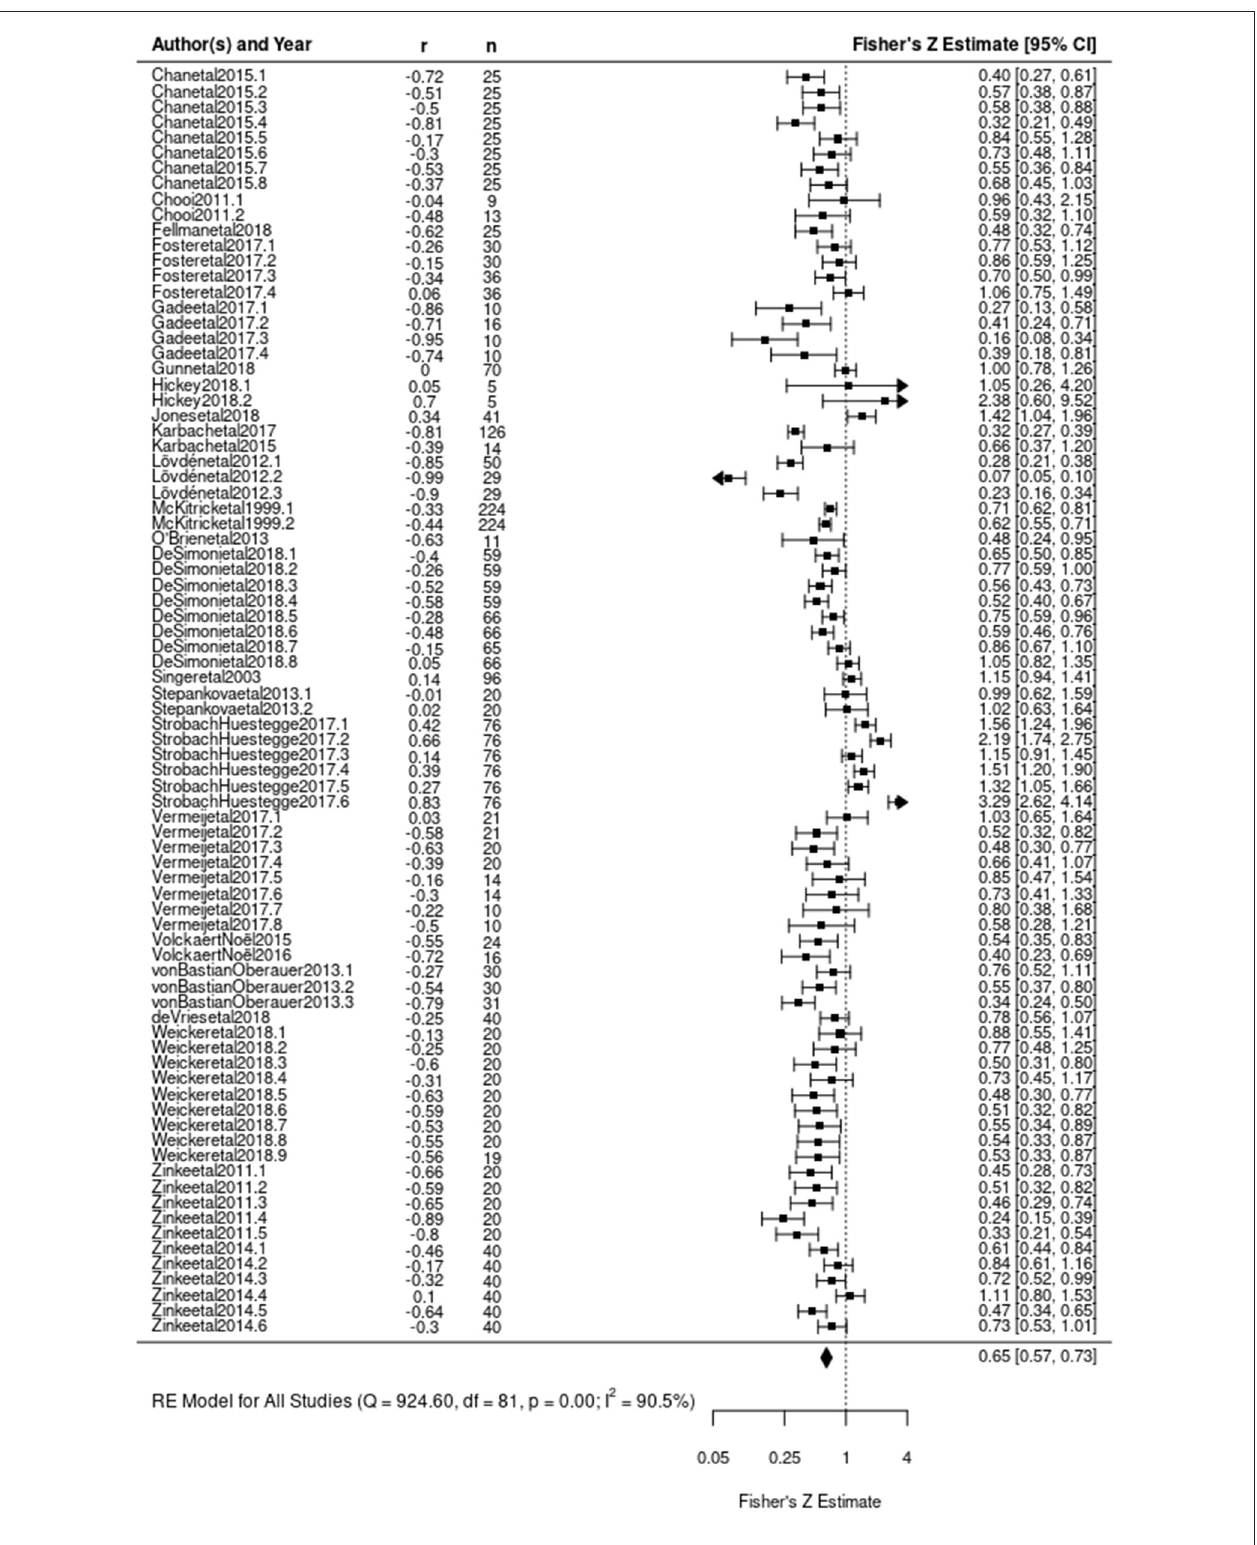
Frontiers in Psychology |